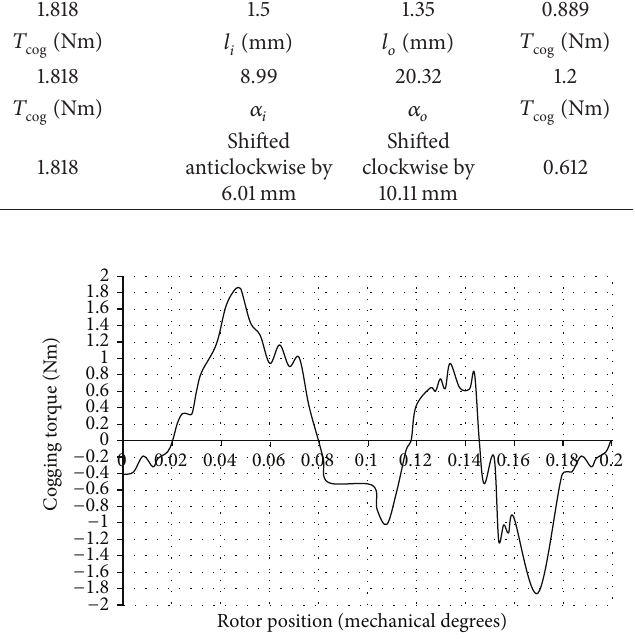
Figure 4: Cogging torque waveform of DRFPMG.